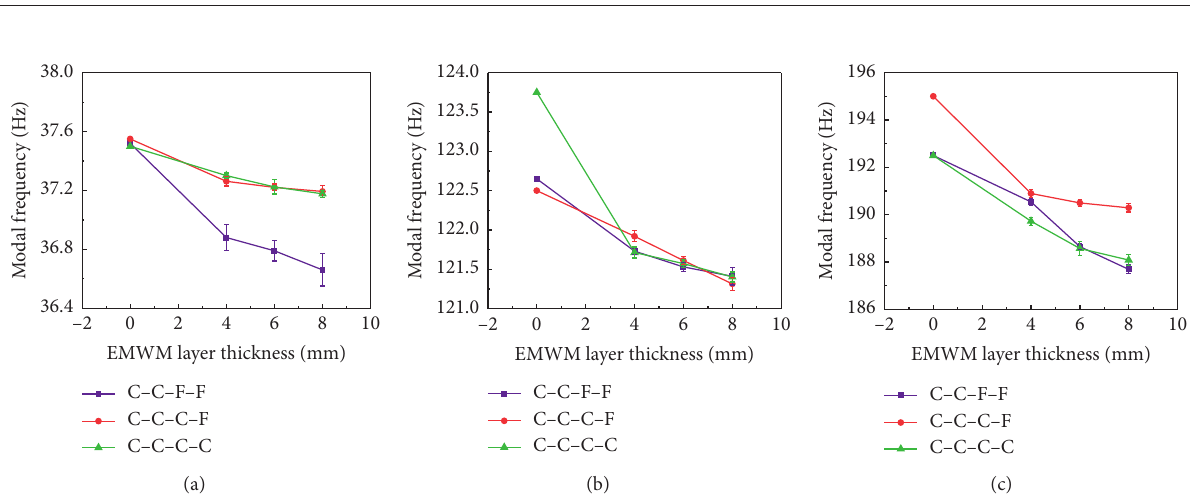
Figure 11: The first three modal frequencies of the steel plate (baseplate) and composite structures with different core thicknesses under different boundary conditions. (a) First order, (b) second order, and (c) third order.